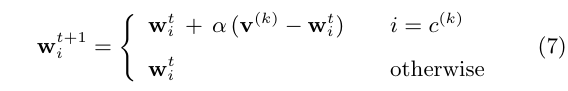
Figure 2: Gist+RatSLAM: GSOM based data association front-end for the RatSLAM algorithm. For each image in a sequence, its Gist features are computed and presented to the network. A neuron familiar to this input would show high activation (as indicated by a red circle in the GSOM network) being at minimum . For a novel input a new neuron is created to learn the pattern. distance d (2) 2 best matching